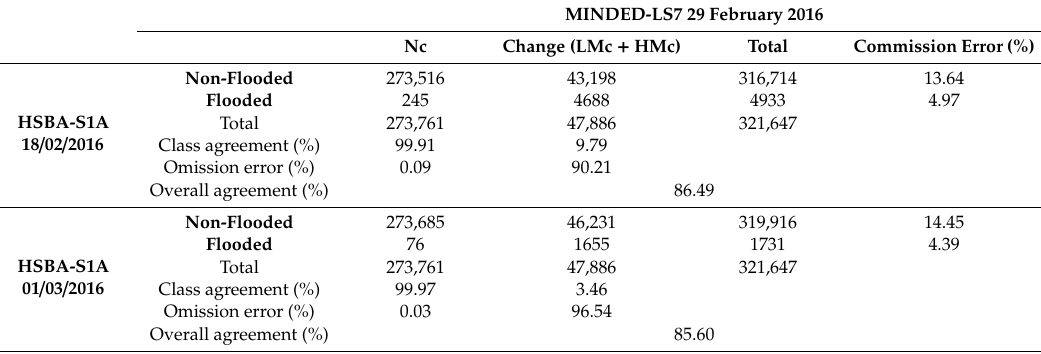
Table 9. Confusion matrix between results of MINDED and HSBA methods, analyzed in terms of No Change (Nc) and Flooded areas (LMc + HMc), for the event of 13 February 2016, within the region of